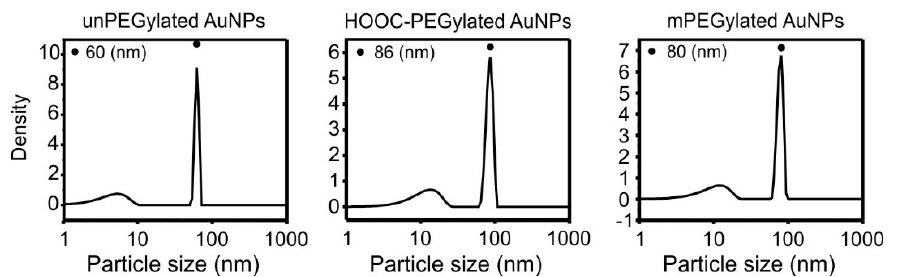
Figure 2. DLS size distributions of colloidal AuNPs unPEGylated (left) and after PEGylation with carboxyl-PEG-SH (center) and mPEG-SH (right) . Three reads were performed using the DLS device, and the SD of the results were as follows: AuNPs unPEGylated (0 nm), after PEGylation with carboxyl-PEG-SH (3.5 nm) and mPEG-SH (3.2 nm). Table 1. Comparation of ζ potential values and particles size between the non-PEGylated and PEGylated gold nanoparticles.